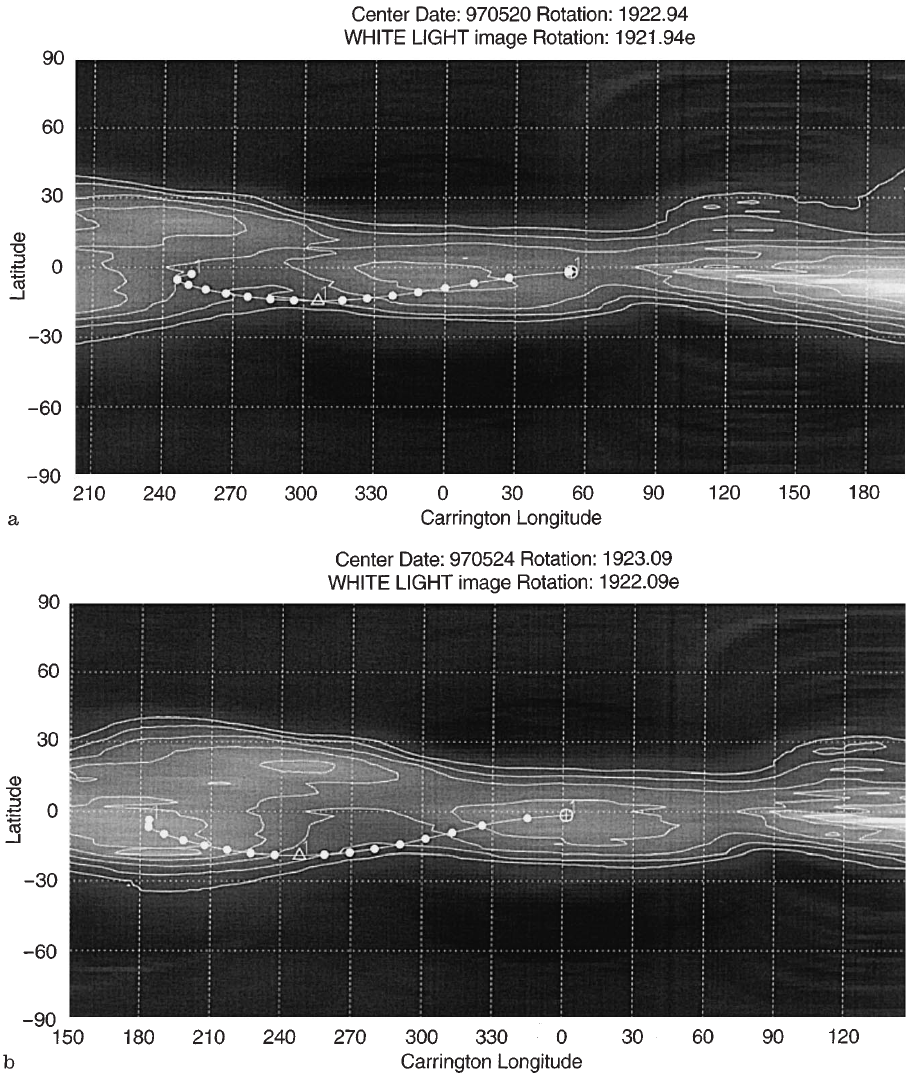
Fig. 12. a White-light map of the corona at 1.7 R , centred on 20 May 1997. The IPS ray-path for the observation of 0431+206 at 36 R is shown projected down to 1.7 R with assumed velocities of 750 km s ) 1 . b White-light map of the corona at 1.7 R , centred on 24 May 1997. The IPS ray-path for the observation of 0431+206 at 22 R is shown projected down to 1.7 R with assumed velocities